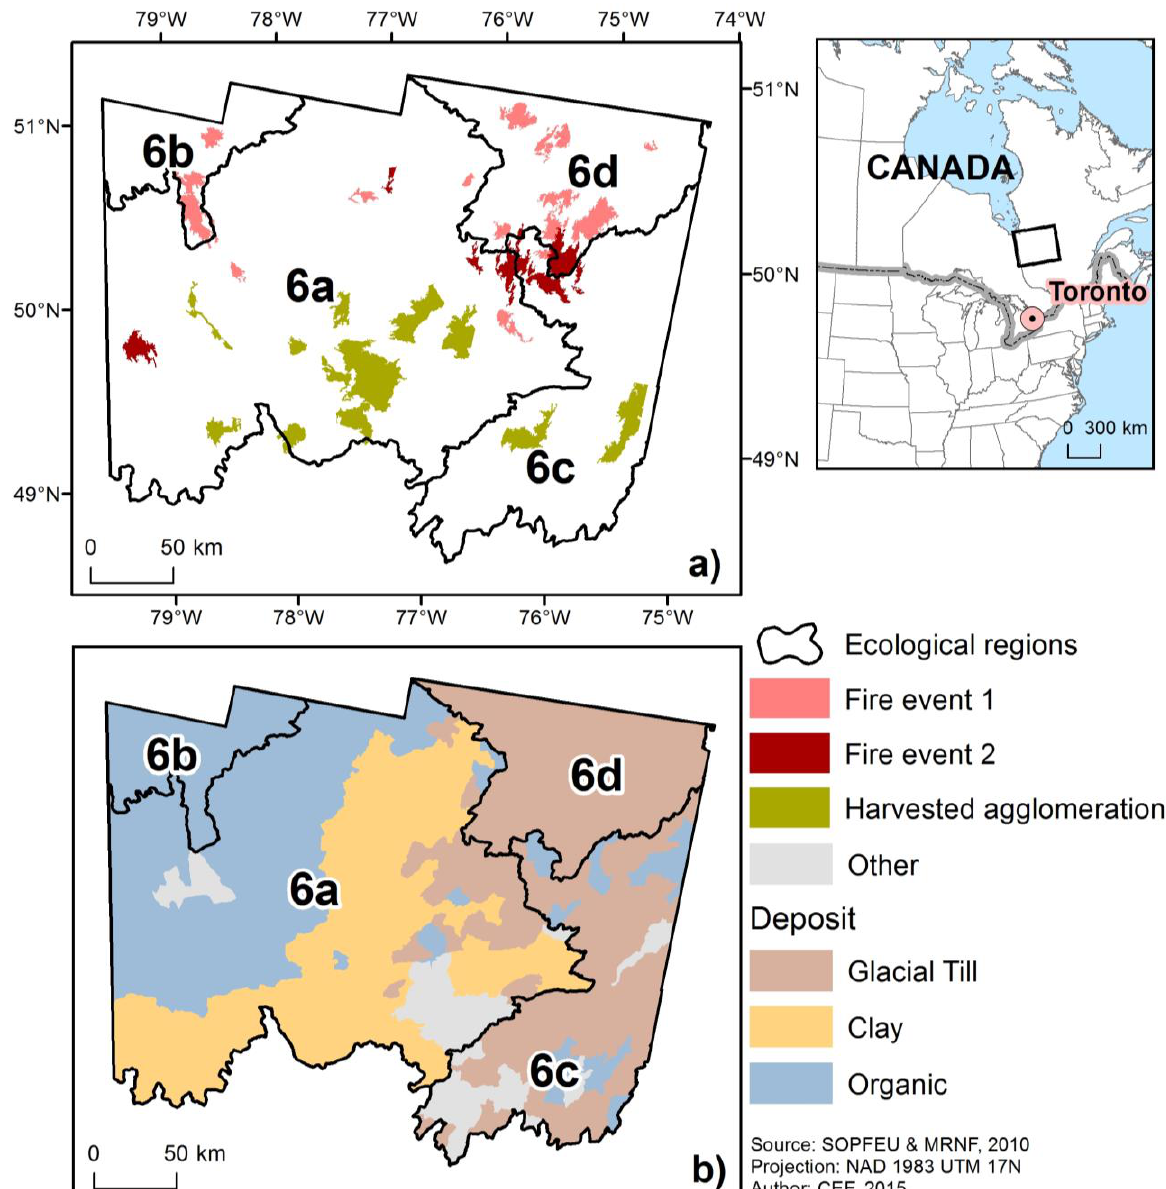
Figure 1. Study area and location of fire event and harvested agglomeration that were sampled. Fire event 1: burned areas where pre-burned mature forest covers <40%; fire event 2: burned areas where pre-burned mature forest covers >40% and for which the provided time since fire (TSF) is mainly between 14 and 19